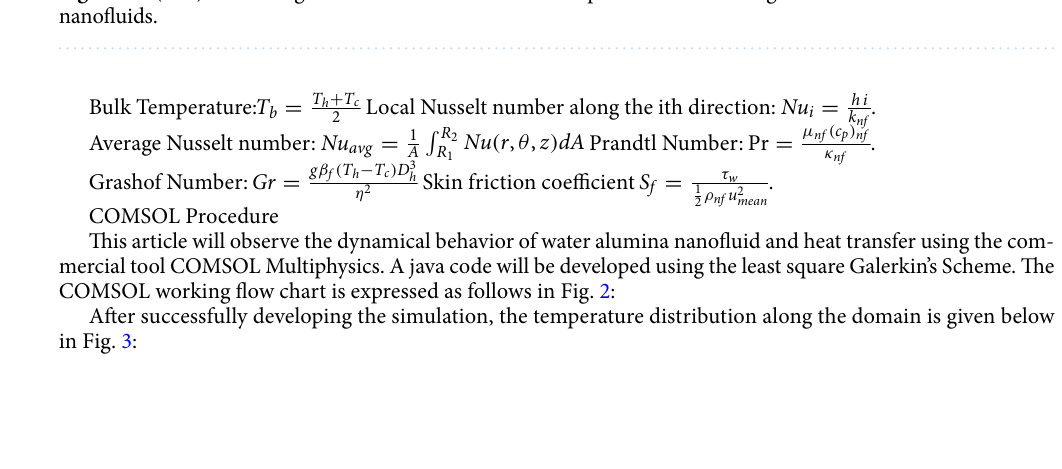
Figure 6. ( a – d ) The average Nusselt number at the middle plane with increasing volume fraction of the